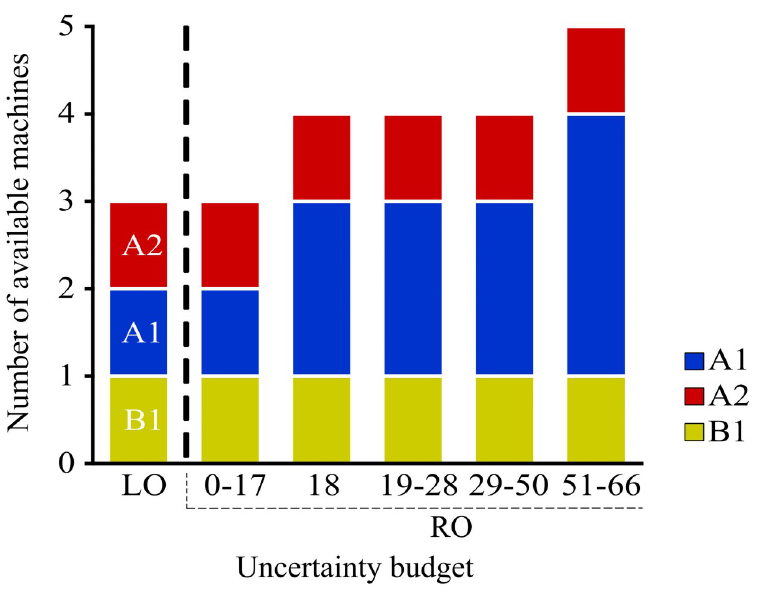
Fig 6. Investment plan for each level of uncertainty LO and RO